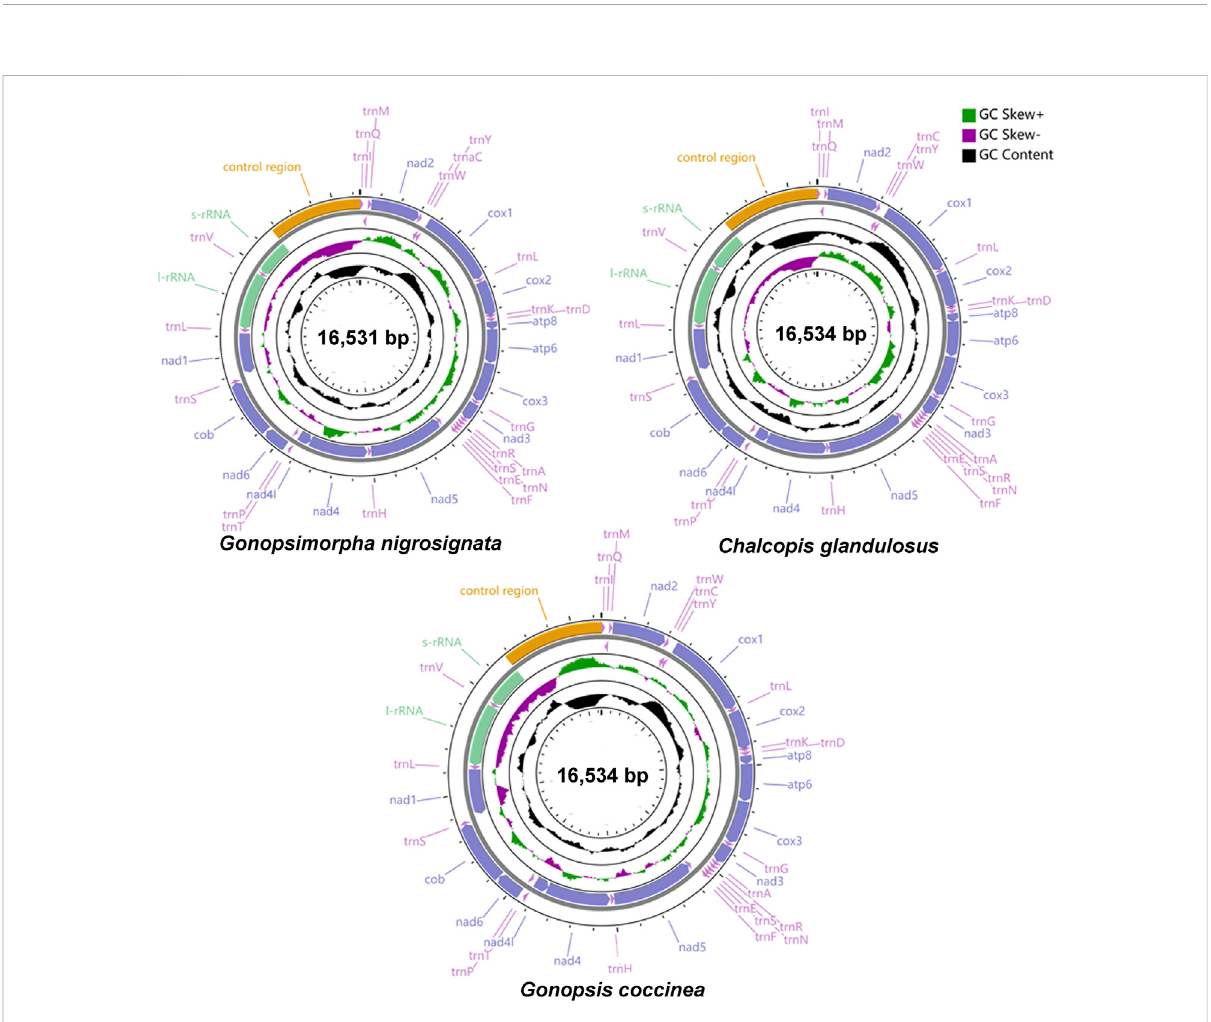
FIGURE 1 Gene structure of three complete mitochondrial